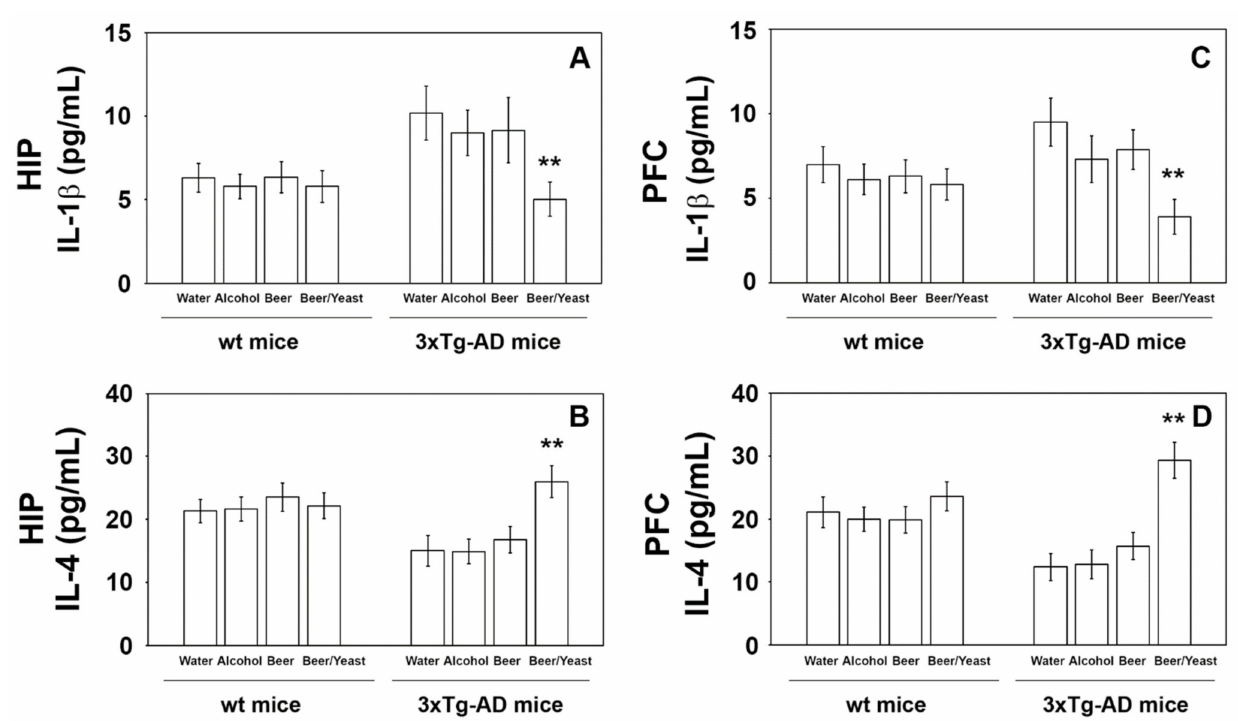
Figure 6. Levels of IL-1 β ( A – C ) and IL-4 ( B – D ) measured by ELISA on brain homogenates of the wt and 3xTg-AD mice treated with water, alcohol, beer and beer/yeast. IL-1 β and IL-4 showed, respectively, a decreased and an increased concentration in the HIP and PFC of B/Y-treated 3xTg-AD mice. Concentrations are expressed as pg/mL. HIP: hippocampus; PFC: prefrontal cortex. (** p < 0.01, B/Y vs. W, A and